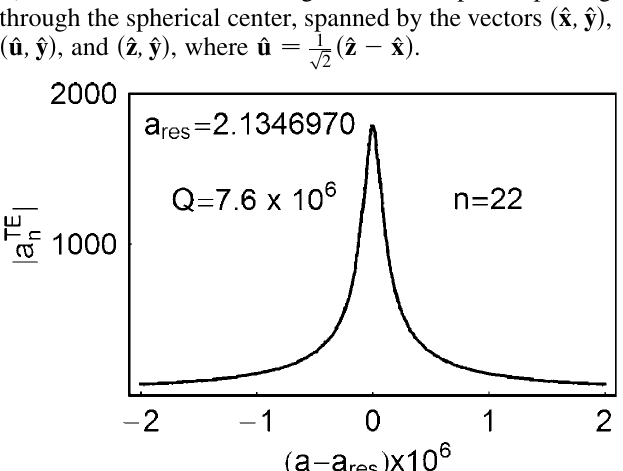
FIG. 2. Resonance curve for the TE, l (cid:2) 22 ,